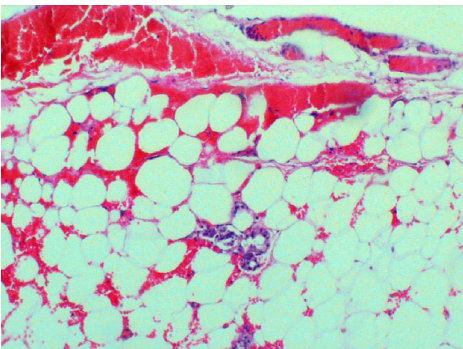
Figure 2. Congestion in the vessels with marked edema and hemorrhage in the adipose tissue are seen after ischemia- reperfusion (H&E, × 50).